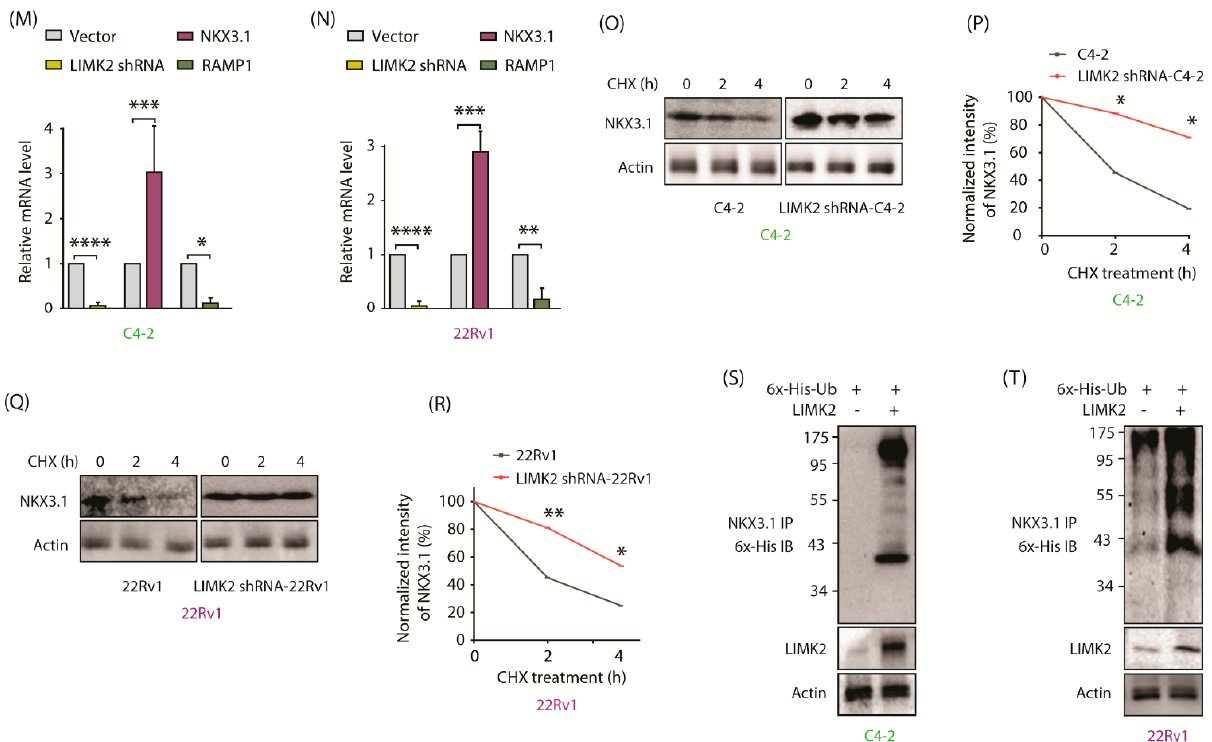
Figure 2. LIMK2 negatively regulates NKX3.1 levels. ( A ) Overexpression of LIMK2 decreases NKX3.1 protein level in C4-2 cells. C4-2 cells were infected with LIMK2 retrovirus and harvested after 33 h; ( B ) Quantitative analysis of LIMK2 and NKX3.1 protein levels from three independent experiments. * p < 0.05, ** p < 0.01; ( C ) LIMK2 overexpression